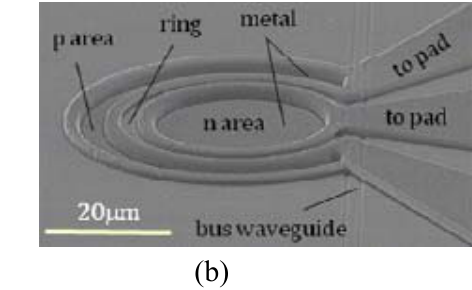
Figure 9. Cross section (a) and top view SEM image (b) of the fabricated